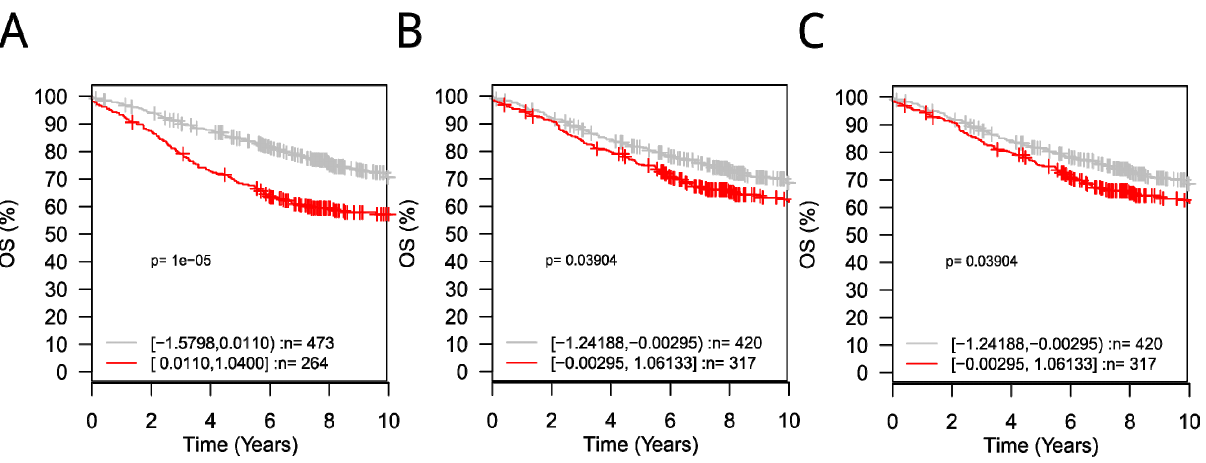
Figure 4. Validation of let-7c result. Gene expression-based outcome for breast cancer online (GOBO) survival analysis of let-7c-regulated PIN members marked with the following functions: Microtubule Negative regulation of programmed cell death; and ( C ) negative regulation of cell death. Red : samples with high expression of selected gene set (PIN members); grey : samples with low expression of selected gene set (PIN